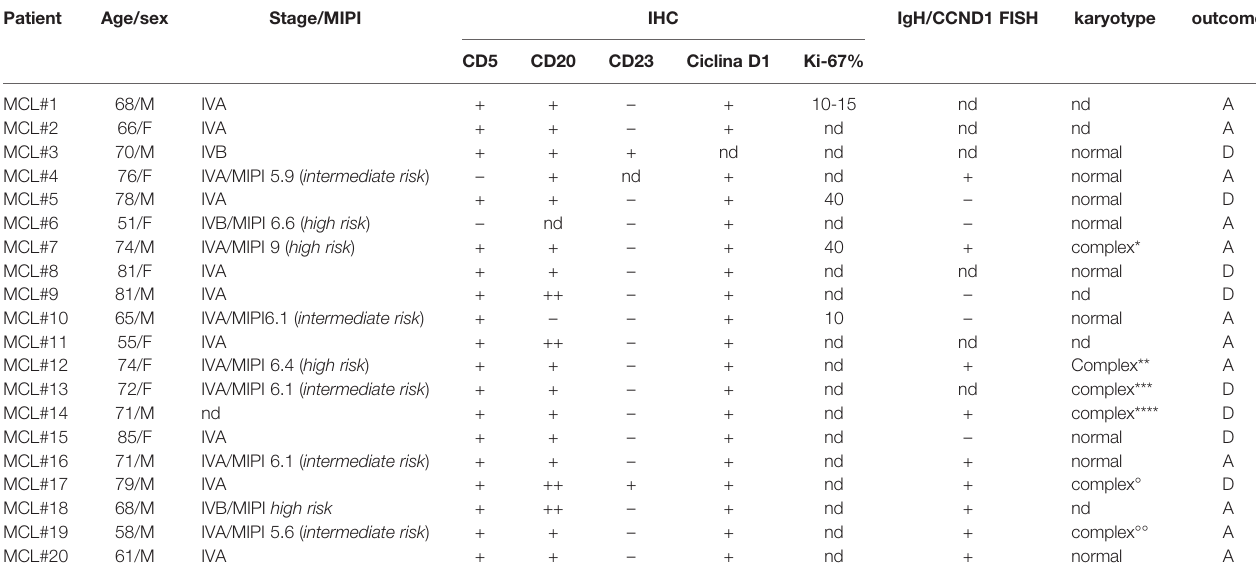
TABLE 1 | Clinical and pathological features of MCL cases